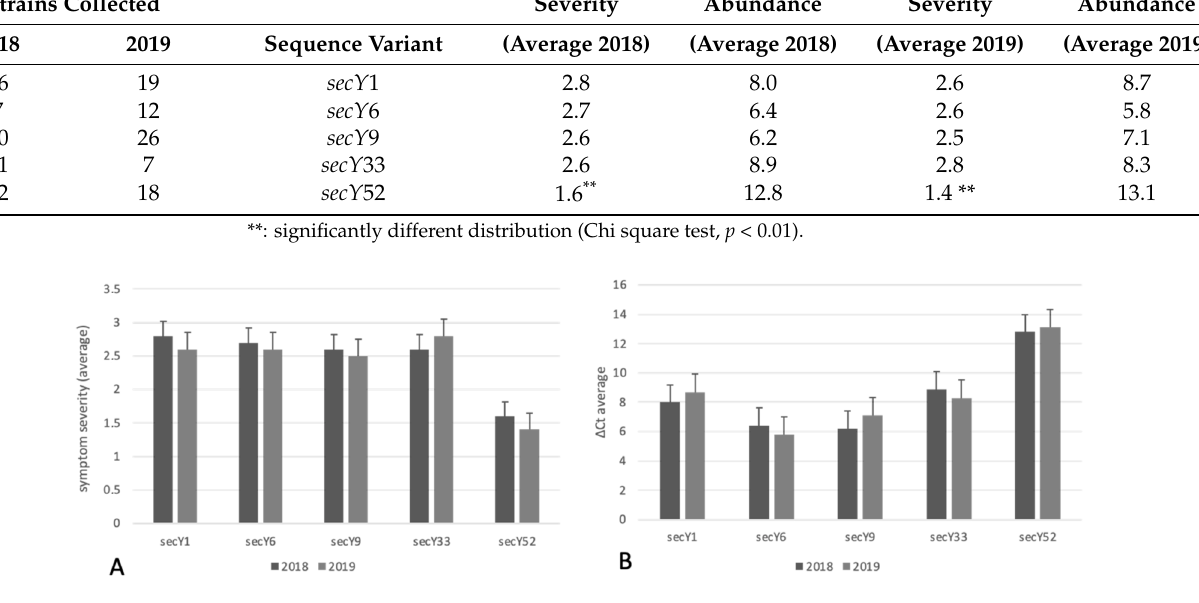
Figure 2. Count of ‘ Ca. P. solani’ strains with different secY sequence variants identified in grapevines showing different symptom severity ( A ) and relative concentrations ( B